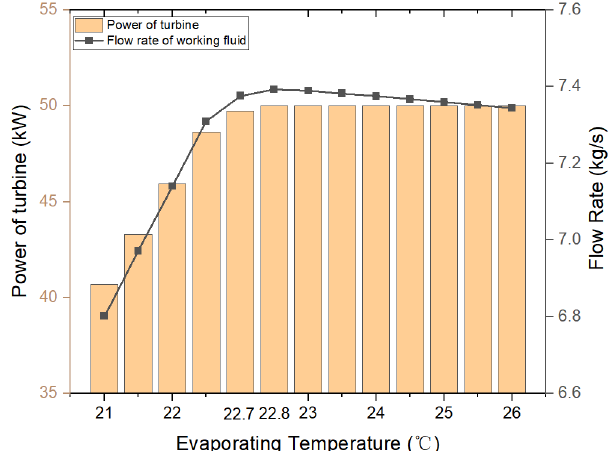
Figure 5. The output power and working fluid flow rate.